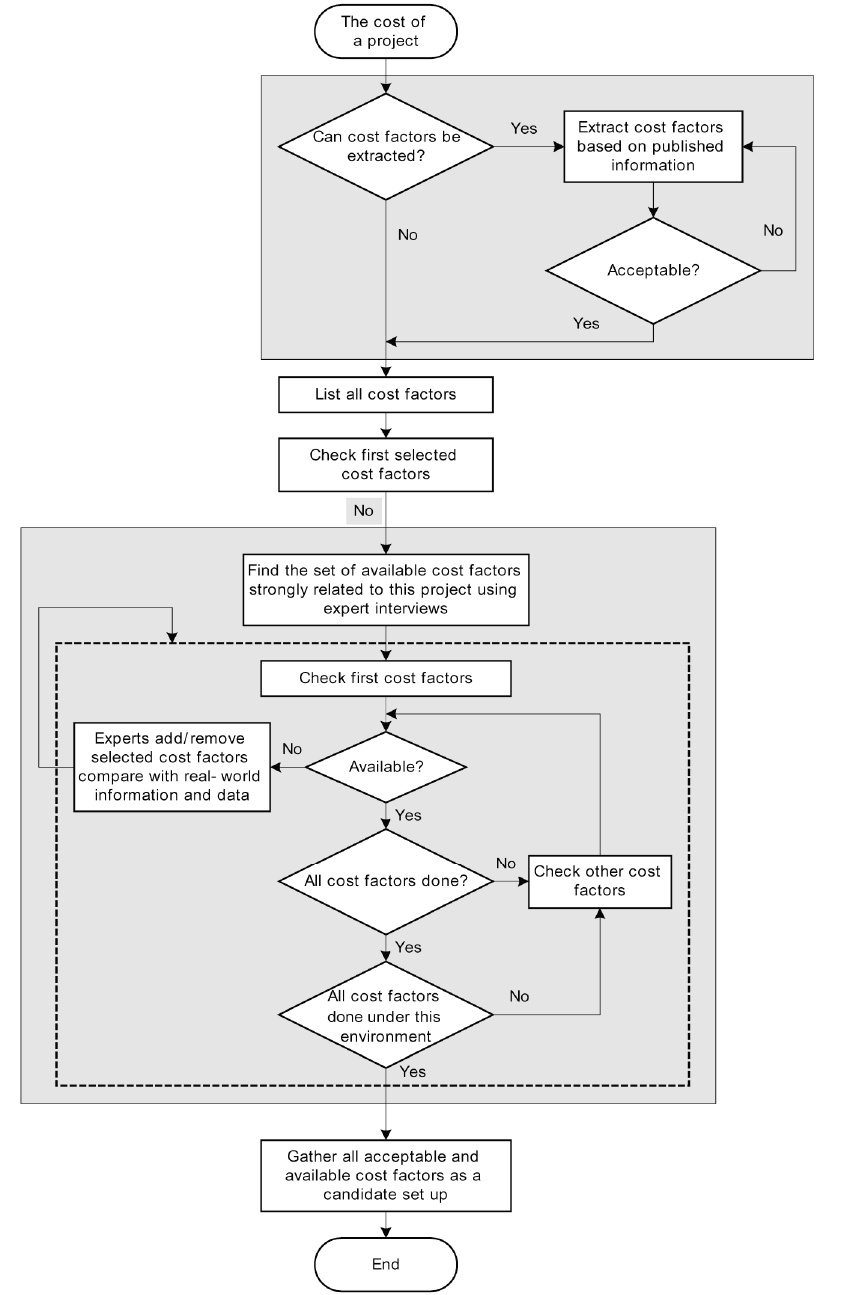
Fig. 2. Procedure of selection of relevant